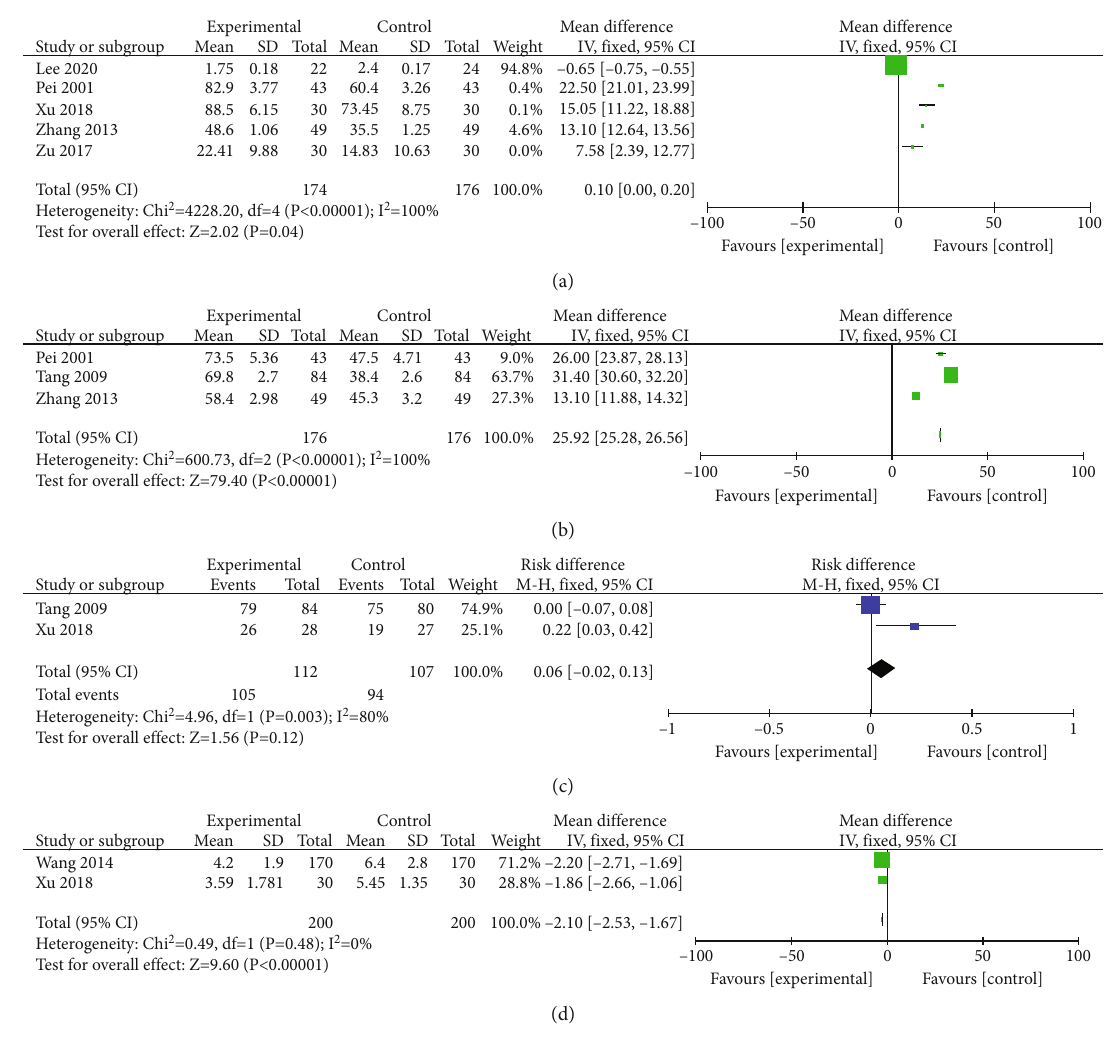
Figure 3: The e ff ects of electroacupuncture on BI, Fugl-Meyer index, CSS, and NIHSS of cerebral infarction: BI (a), Fugl-Meyer index (b), CSS (c), and NIHSS (d) of cerebral cerebral infarction ( mean difference = 25 : 92 , 95% CI: 25.28- 26.56, p < 0 : 00001 ).